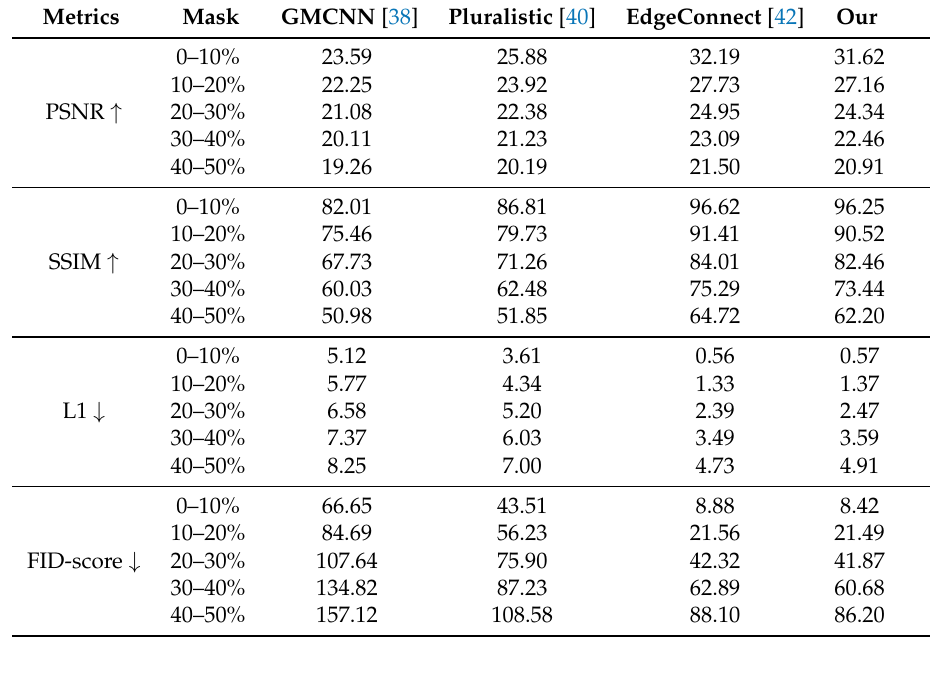
Table 2. Comparison of our inpainting results to three state-of-the-art non-blind inpainting algorithms. Notation: ↑ Higher is better. ↓ Lower is better.